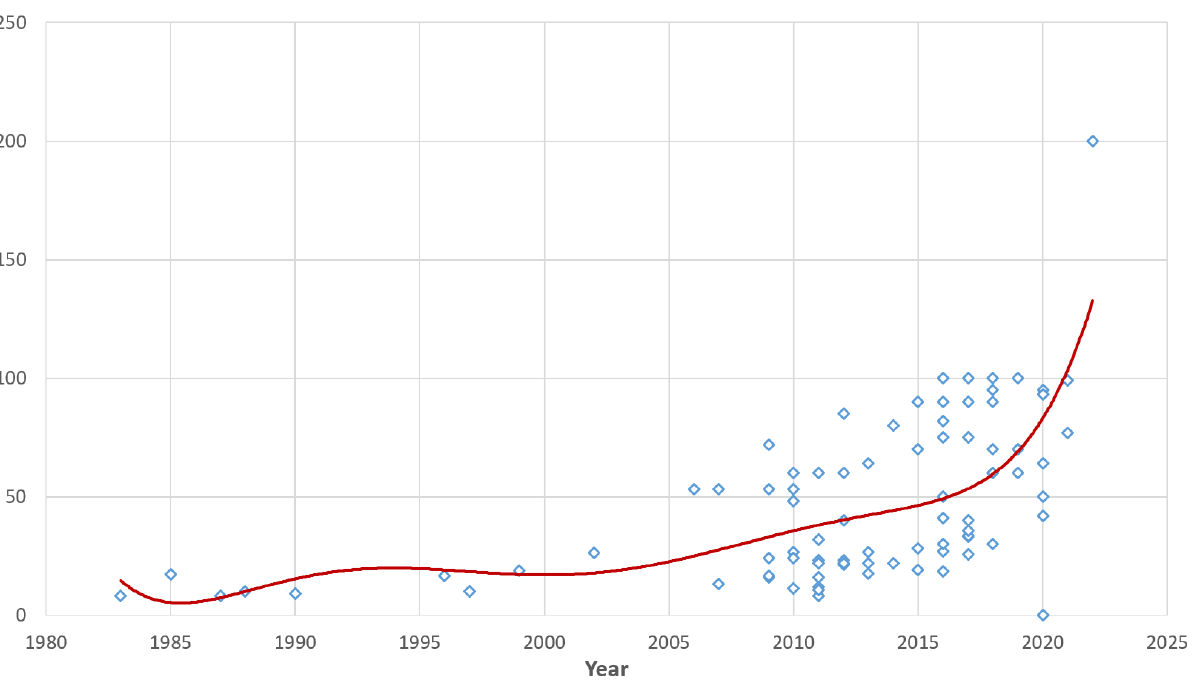
Figure 5. Evolution of the battery capacity since the mid 80s until